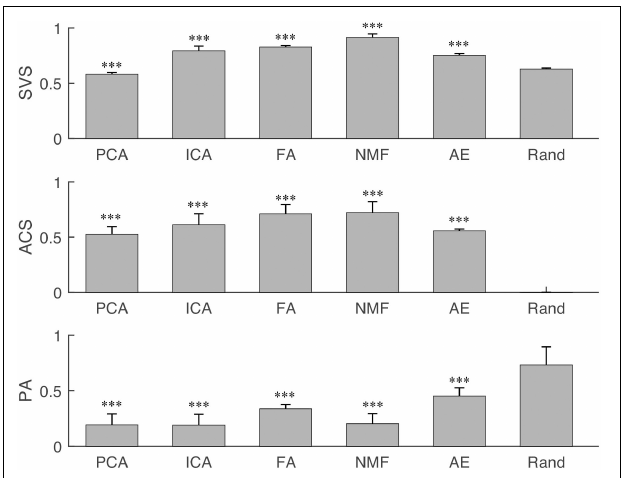
FIGURE 4 | The synergy similarity of the extraction methods and random data. Three panels from top to bottom are synergy vector similarity (SVS), activation coefficient similarity (ACS), and principal angle (PA). The last bar in each panel “Rand” is the similarity between randomly generated data and the simulated data. The star shows the significance level between methods and Rand. “ ∗∗∗ ” indicate the significance levels are 0.05, 0.01, and 0.001, respectively.